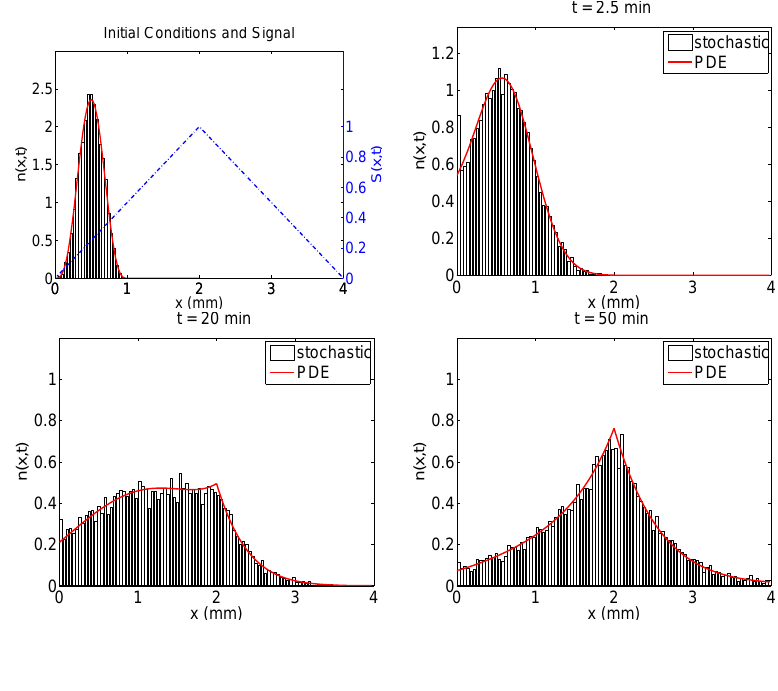
Figure 10. Comparison of solutions of the derived PDE (21) with stochastic simulations of the cell-based model. Parameters used: s = 20 µ/ s, λ = 1 , b = 4 . 10 4 cells are used for the 0 0 cell-based model. Bars: histogram of the cell positions computed from the cell-based model with a total number 10 4 cells. Red lines: numerical solutions of Equation